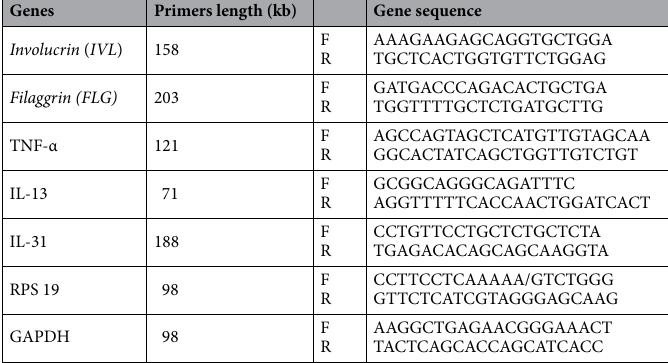
group in a similar fashion. Total RNA was extracted from the skin tissues by using the PureLink® RNA mini kit. The RNA from blood was extracted by the manual method by using TRIZOL reagent and a phenol/chloroform/ isopropyl alcohol method. Isolated RNA was checked for its purity and concentration by using Eppendorf Bio- photometer plus. Absorbance was recorded at 260 nm and 280 nm against nuclease-free water as blanks. RNA samples showing A 260/280 value 1.8 in the PBMCs and ratio 1.9–2.0 in the skin samples were used. RNA with a concentration up to 1000 ng was used for cDNA synthesis.